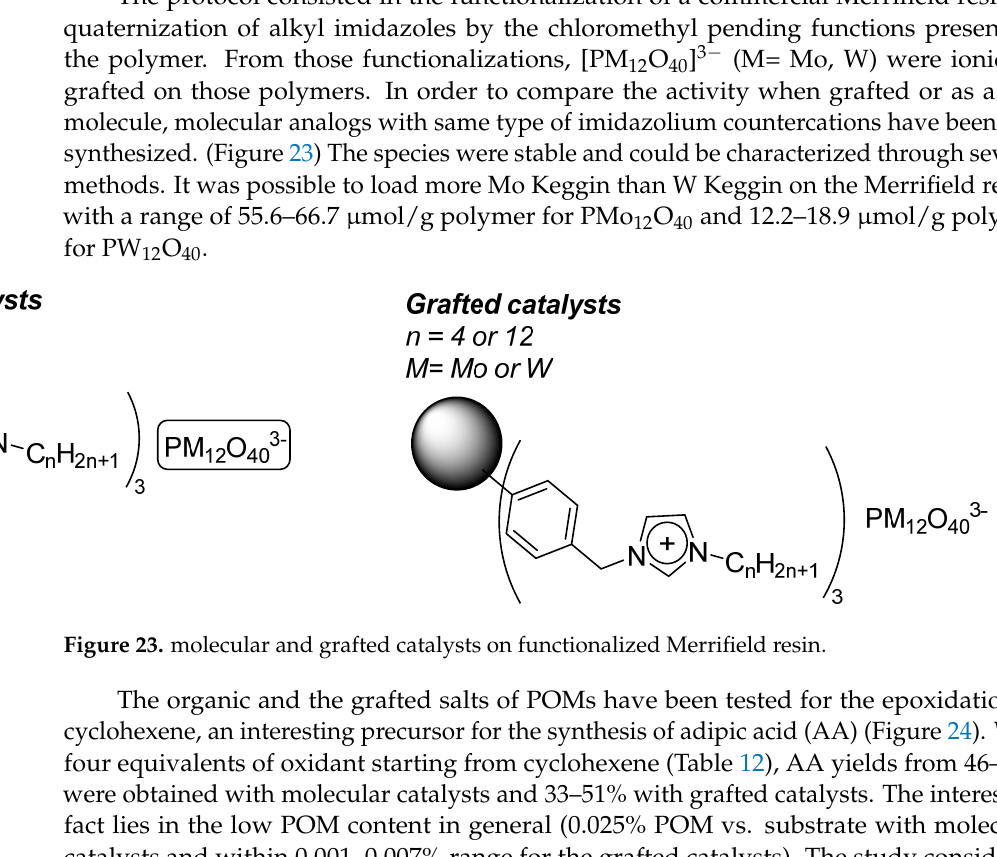
Table 11. CO epoxidation under organic solvent free conditions with organic salts of POMs from Figure 22. TBHP/cyclooctene = 1.5, 24 h, 80 °C.